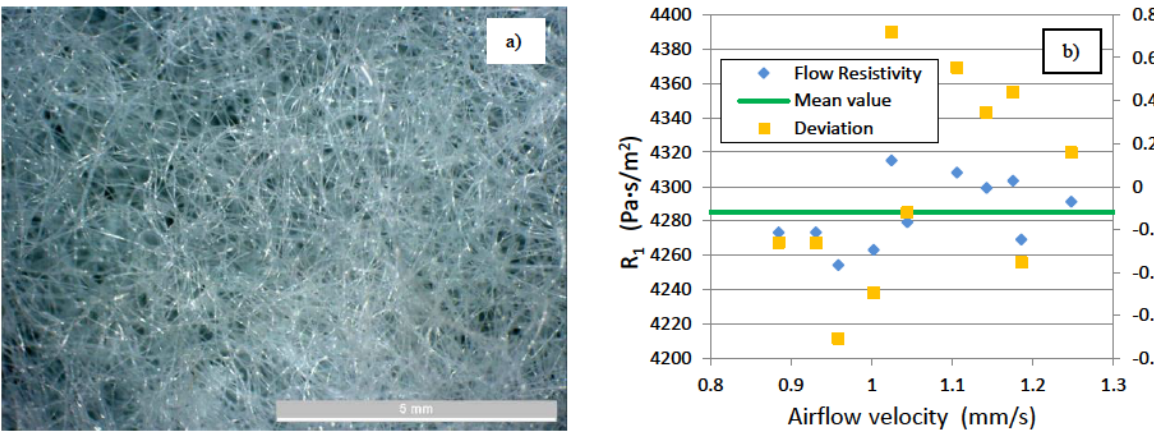
Figure 6: Microscopic structure (a) and R f measurements (b) for un-faced polyester fiber samples